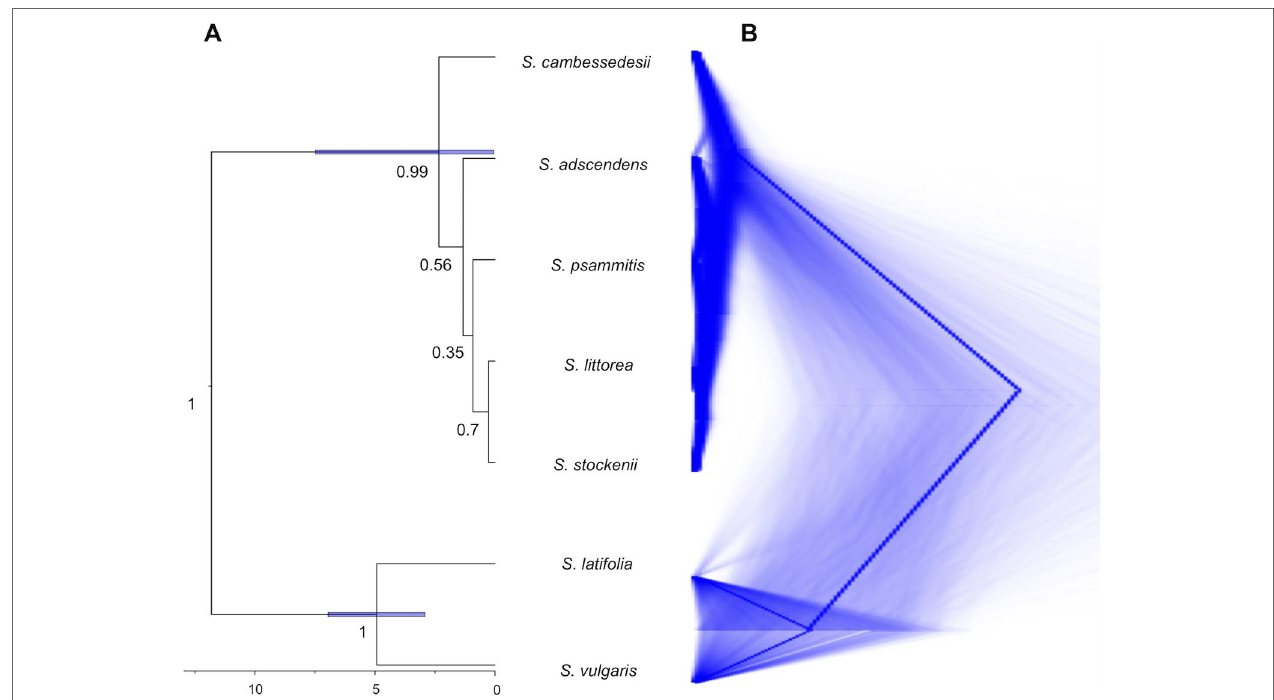
FIgURe 4 | Species tree reconciliation analysis. (a) *BEAST multispecies coalescent with posterior probabilities over branches and node age estimates (95% HPD) with posterior probability limit set up to 0.90 (strong support). (B) DensiTree visualization of the posterior distribution of gene trees obtained from *BEAST.